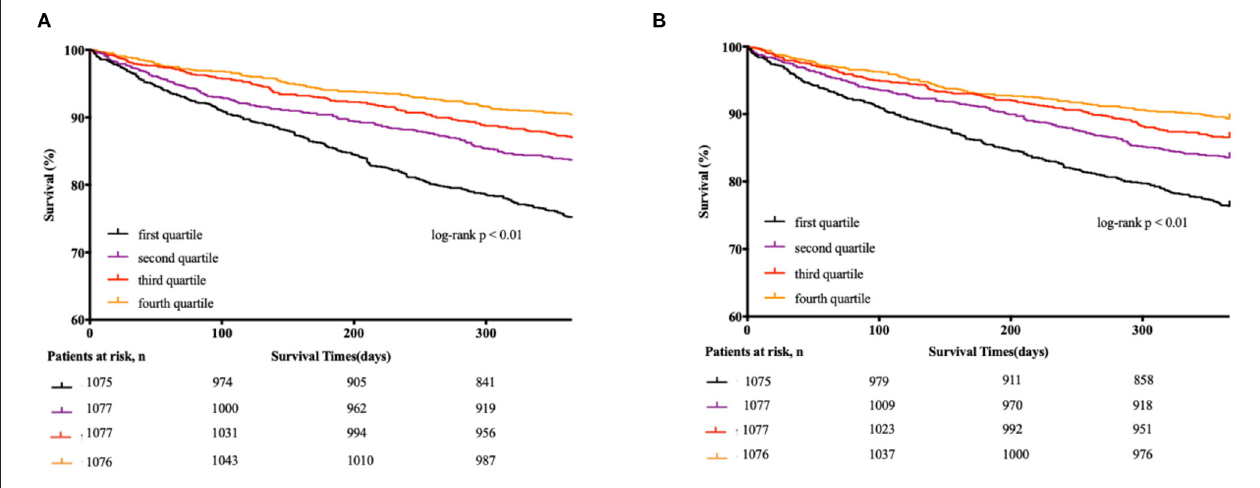
FIGURE 1 | Kaplan-Meier estimates of 1-year all-cause mortality according to quartiles of each body component. (A) Kaplan-Meier curve according to quartiles of LBM index for the all-cause mortality. (B) Kaplan-Meier curve according to quartiles of FM index for the all-cause mortality.